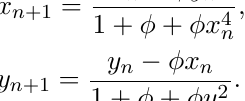
Figure 5. The numerical solutions obtained by the NSFD scheme with h = 1 after 50 iterations in Example 3.